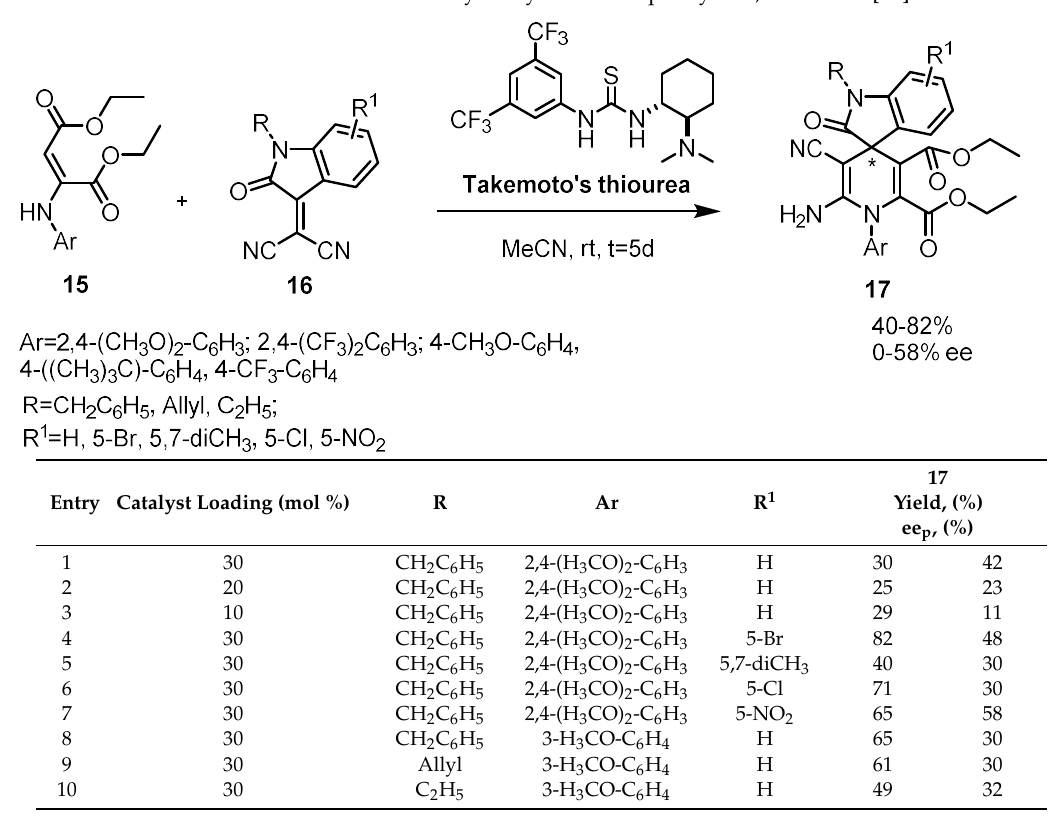
Table 8. Takemoto’s thiourea catalysed synthesis of spirocyclic1,4-DHPs 17 [62].